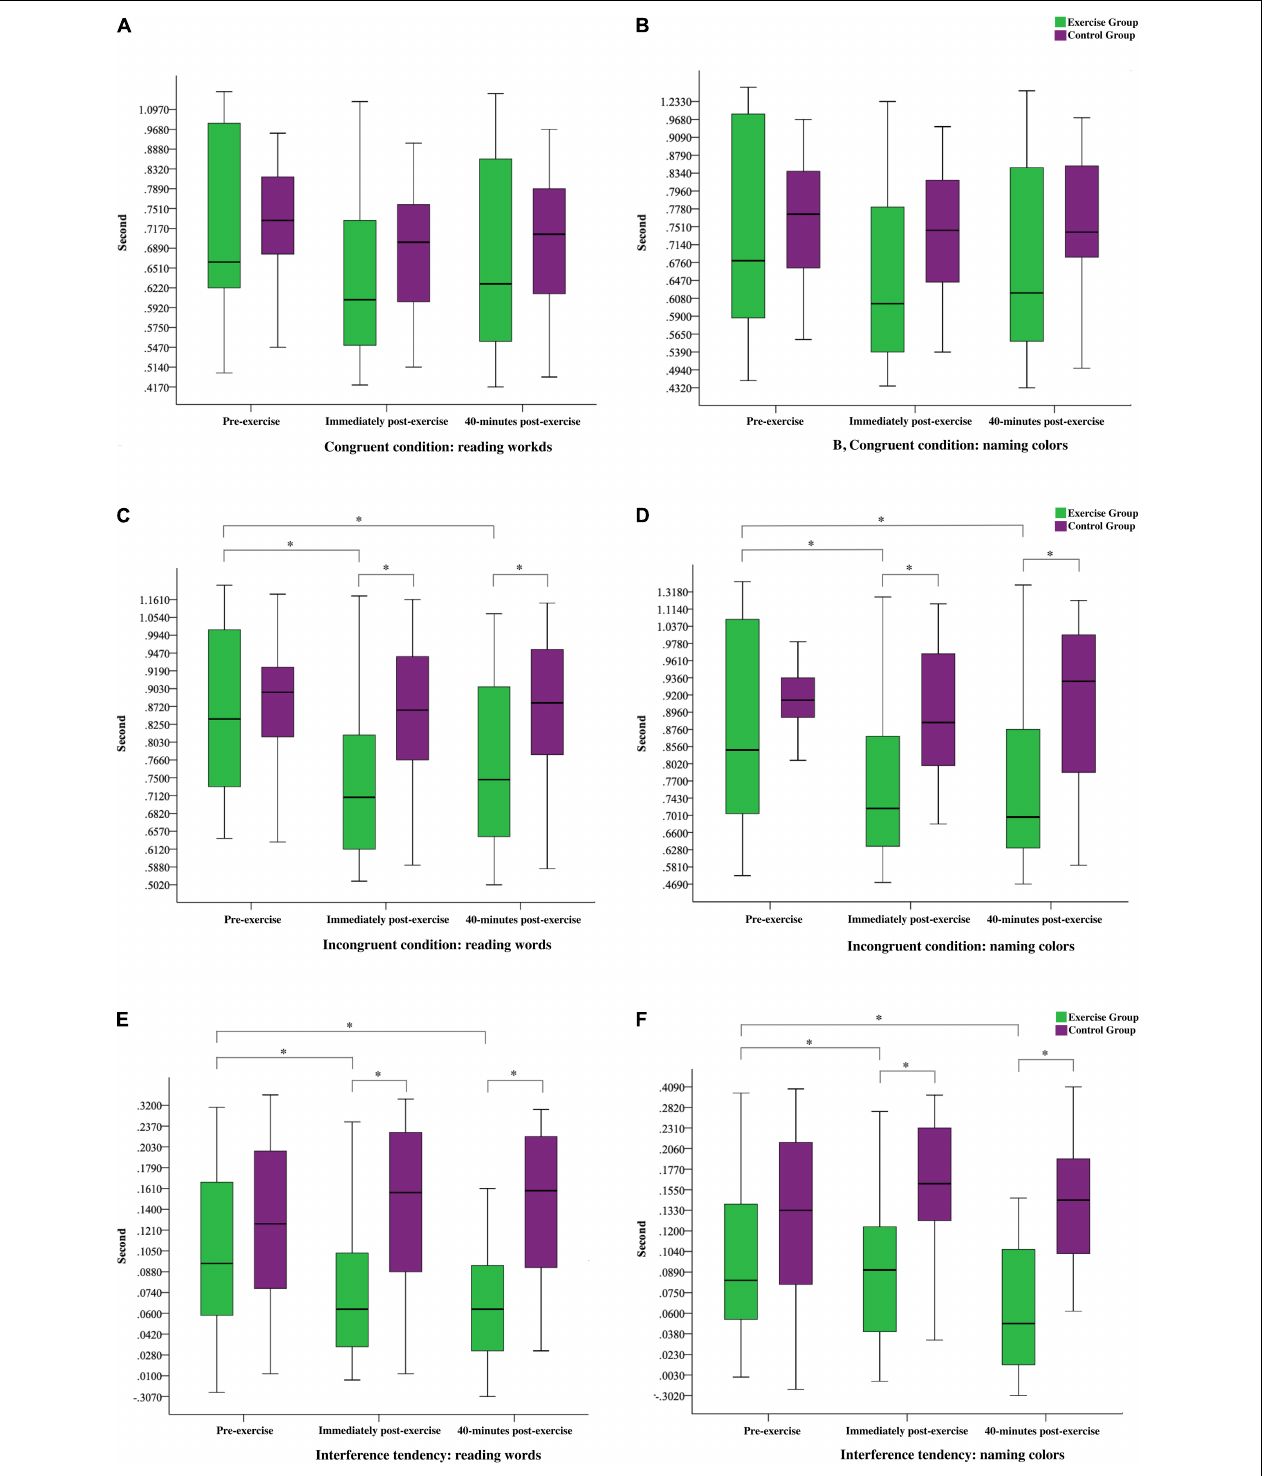
FIGURE 1 | Stroop test performance on the pre-exercise, immediately post-exercise, and 40-min post-exercise; green indicates exercise group and purple indicates control group ∗ indicates a significant difference ( p < 0.05) between the exercise and control groups or between pre-exercise, immediately post-exercise, and 40-min